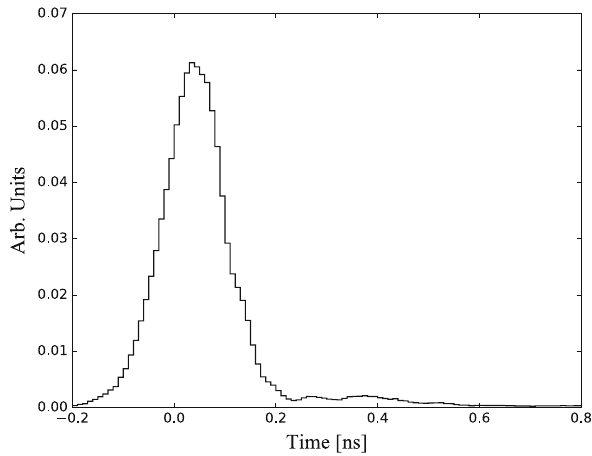
Fig. 2 The LAPPD transit time distribution as measured and provided by Incom Inc. [43]. The TTS (standard deviation) is about 70 ps. The distribution has been smoothed for visualization purposes